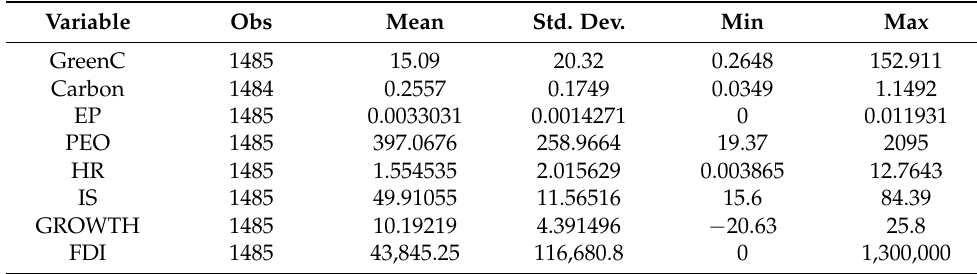
Table 4. Descriptive statistics for